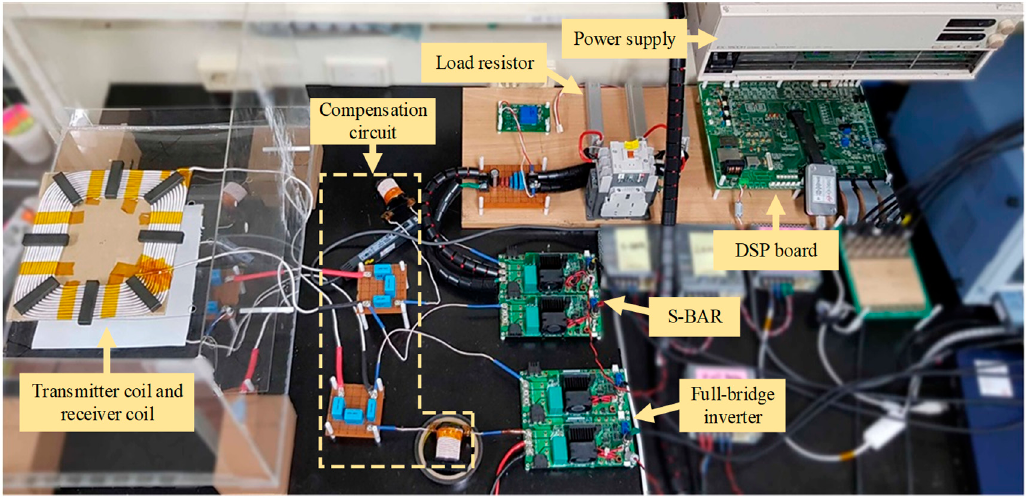
Figure 11. Experimental setup.